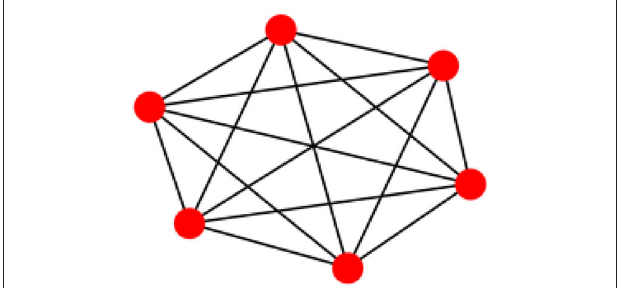
Figure 9 visualizes two real Twitter networks. The yellow nodes represent the ego, while the black links represent Two-way connections and blue links show One-way connections. Using